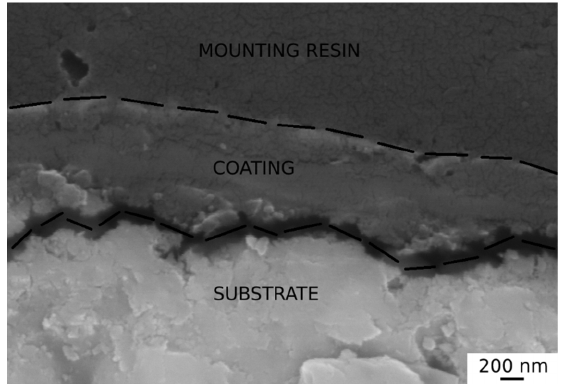
Figure 10. SEM analysis of sample section blackened with solution 2 for 100 min.